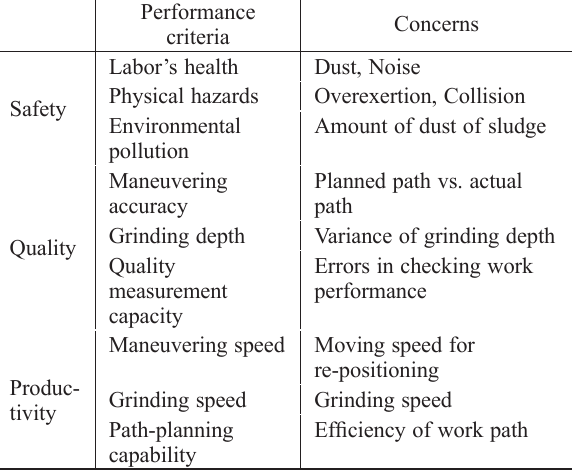
Table 1. Performance criteria for concrete surface